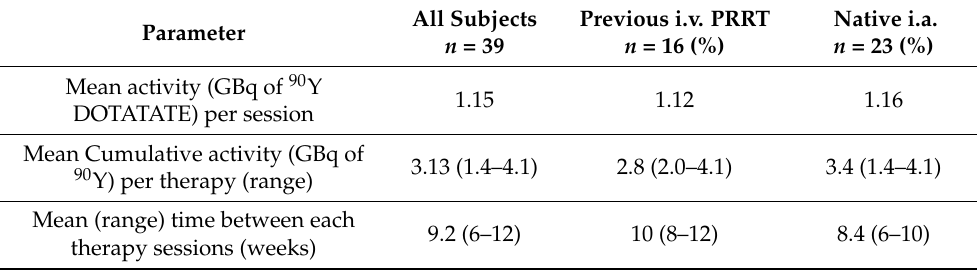
All Subjects Previous i.v. PRRT Native i.a. n = 39 n = 16 (%) n = 23 (%) 1.15 1.12 1.16